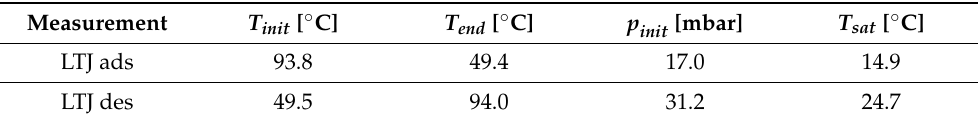
Table 3. Conditions for LTJ measurements. The initial pressure is set and the end pressure depends on the mass of the adsorbent (the more adsorbent the lower the end pressure in the adsorption